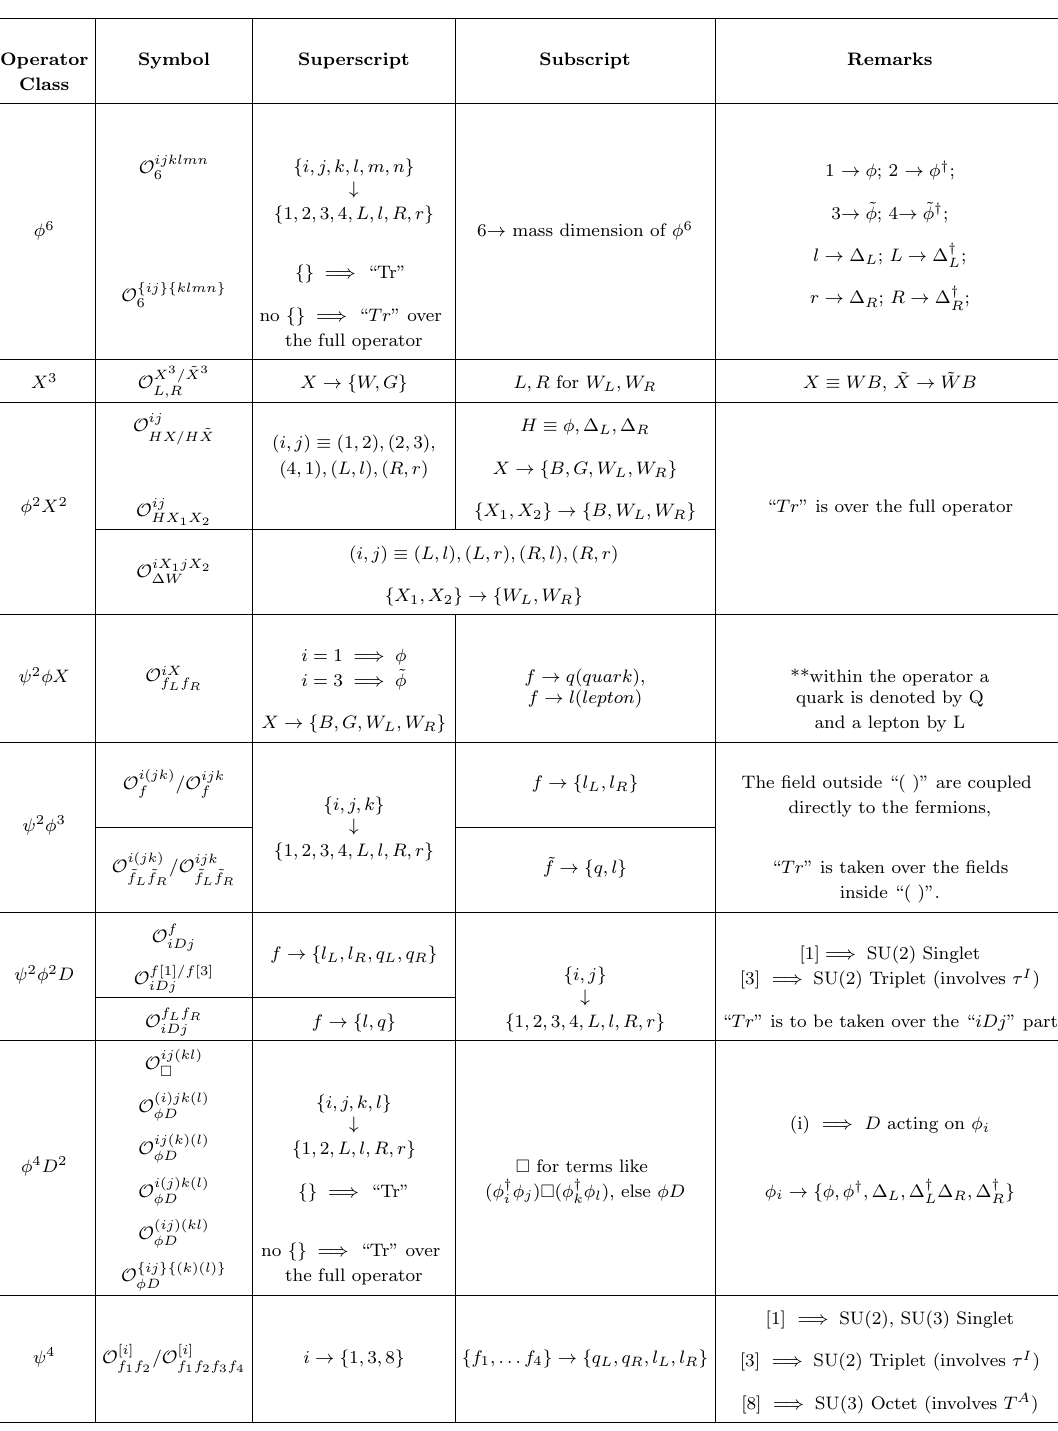
Table 14. MLRSM: summary of the nomenclature of operators. Note: ** | applies to all operator classes. \Tr" | trace must be taken over internal symmetry